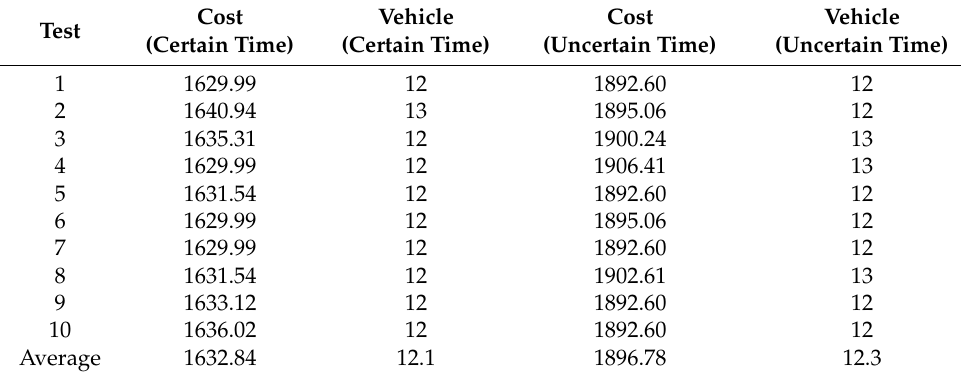
Table 4. Comparison of scheme costs for R101.